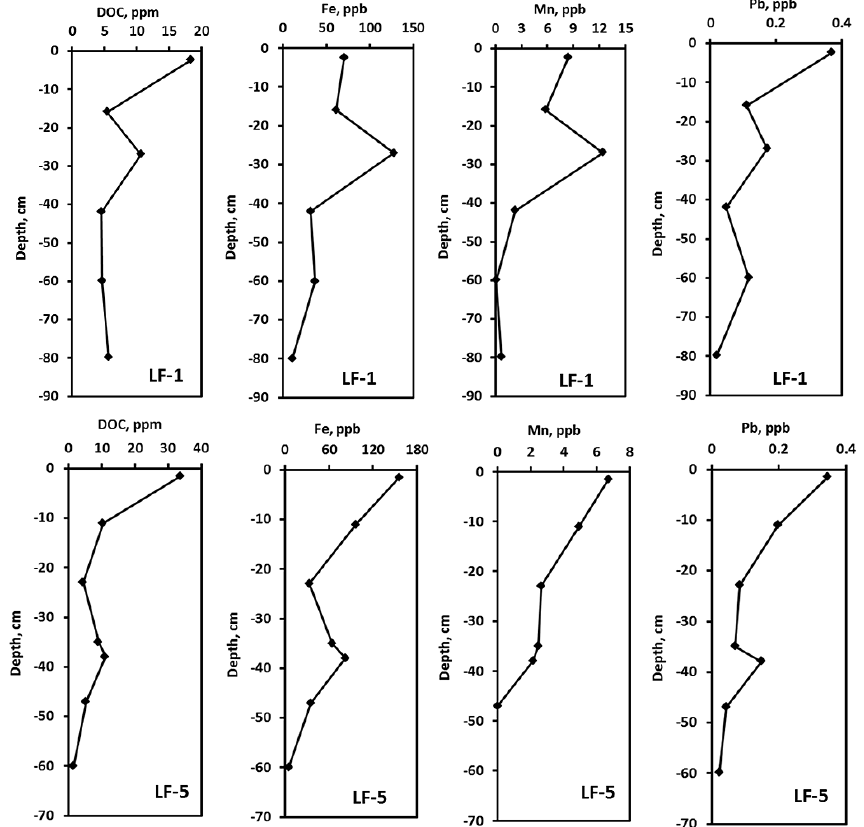
Figure 5. DOC, Fe, Mn and Pb concentrations in the ice cores of thermokarst lakes sampled in February 2014. LF-1 and LF-5 refer to the sampled lakes (Table